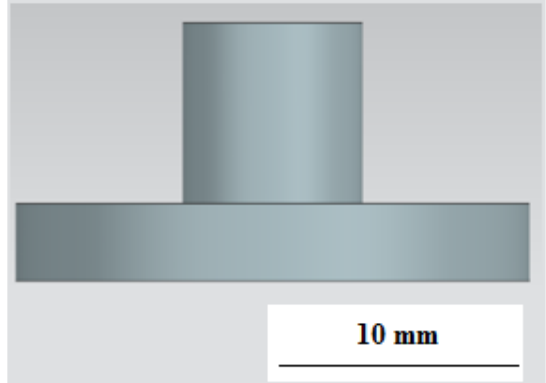
Figure 4. ET model (side view).